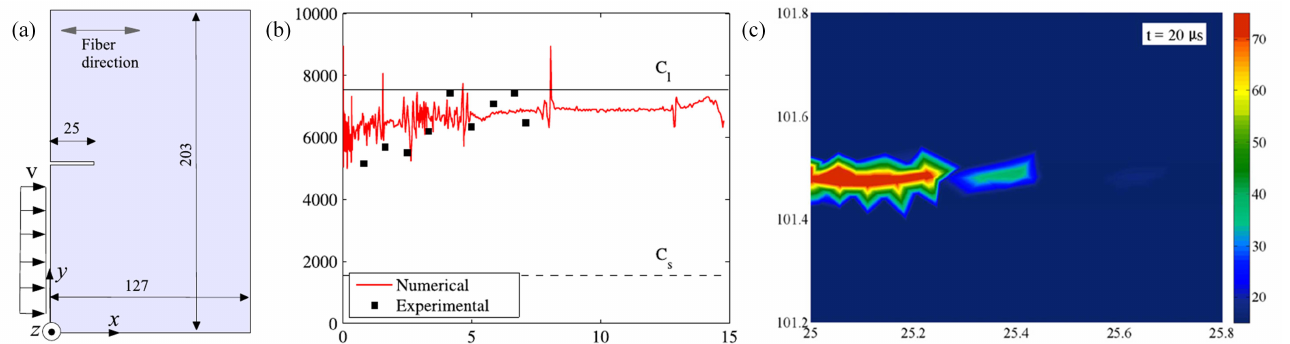
Figure 29. ( a ) Geometry and boundary conditions of a single-edge notch composite plate; ( b ) the crack speed of an intersonically propagating shear crack; ( c ) temperature field ahead of a notch due to fracture at a typical time instant